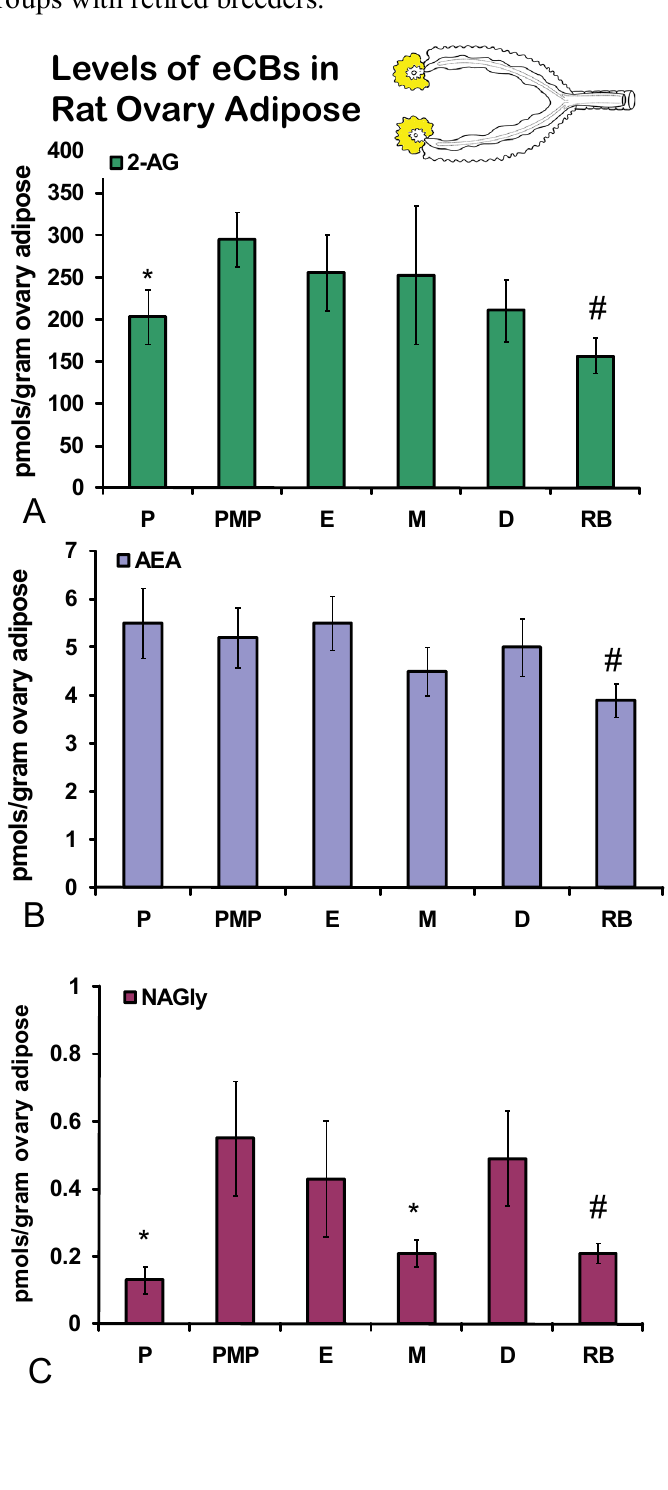
Figure 3. Levels of eCBs in rat ovarian adipose across the hormonal cycle and in anovulatory retired breeders . P = proestrus AM; PMP = proestrus PM; E = estrus; M = metestrus, D = diestrus; RB = anovulatory retired breeders. * p ≤ 0.05 and represents comparisons across the hormonal cycle. # p ≤ 0.05 and represents comparisons of hormonal cycle groups with retired